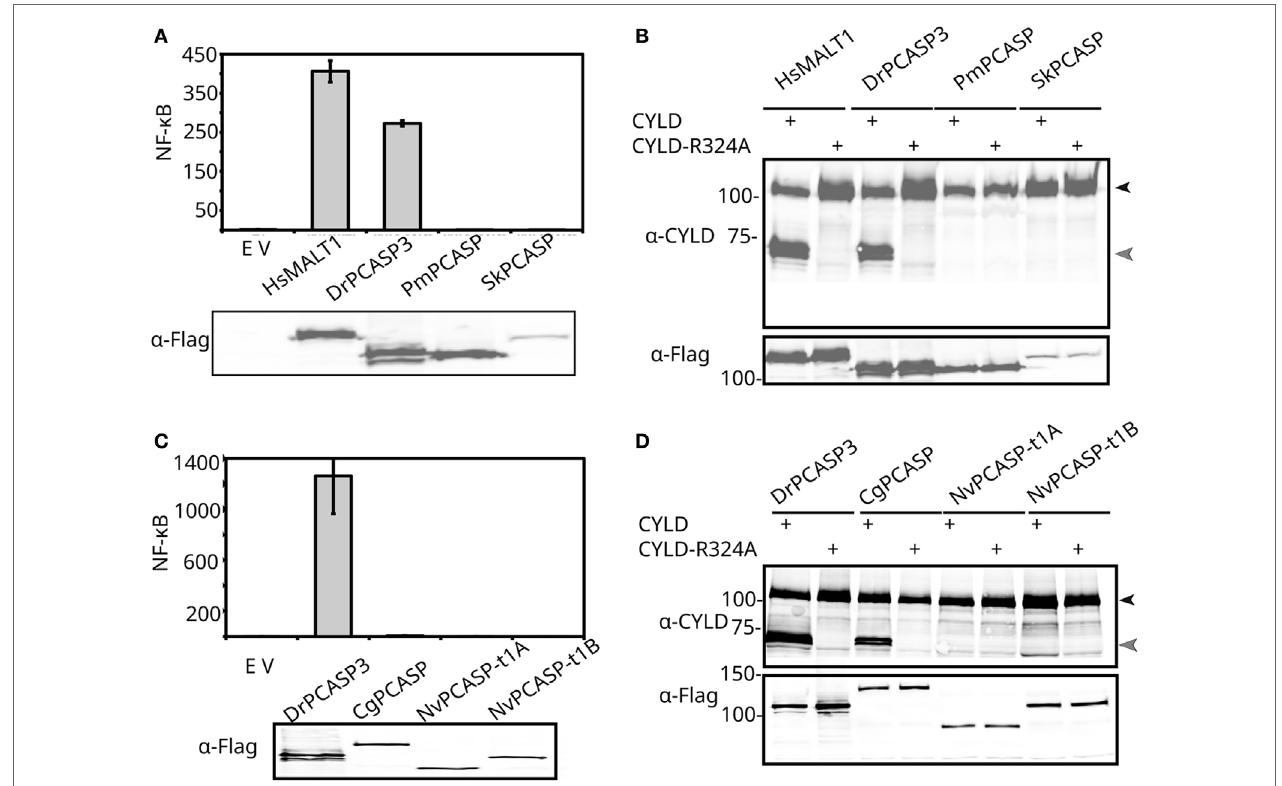
FigUre 2 | Functional conservation of invertebrate paracaspases. (a,c) NF- κ B-dependent luciferase reporter gene induction by HLH-paracaspase fusion proteins. The indicated Flag-tagged HLH-paracaspases were expressed in MALT1-deficient HEK293T cells together with an NF- κ B-dependent luciferase reporter expression plasmid and a constituitively expressed β -galactosidase reporter gene. Luciferase values are normalized against β -galactosidase and expressed as fold induction compared to samples not expressing a HLH-paracaspase (empty vector: EV). Error bars represent 95% confidence intervals [Student’s t -distribution (65)]. The lower part of the panel shows the expression of each HLH-paracaspase as revealed by Western blotting and development with anti-Flag antibodies. Experiments were repeated four times. (B,D) CYLD cleavage by HLH-paracaspase fusion proteins. MALT1-deficient HEK293T cells were transiently transfected with the indicated HLH-paracaspases together with either human WT CYLD or CYLD (R324A) in which the MALT1 cleavage site is mutated. Cell lysates were analyzed for CYLD expression and cleavage via Western blotting and detection with anti-CYLD antibodies. Full-length CYLD is indicated with a closed arrowhead; cleaved CYLD is indicated by an open arrowhead. To show equal expression levels of each HLH-paracaspase, the blot was also developed with anti-Flag antibodies (lower part). Experiments were repeated three